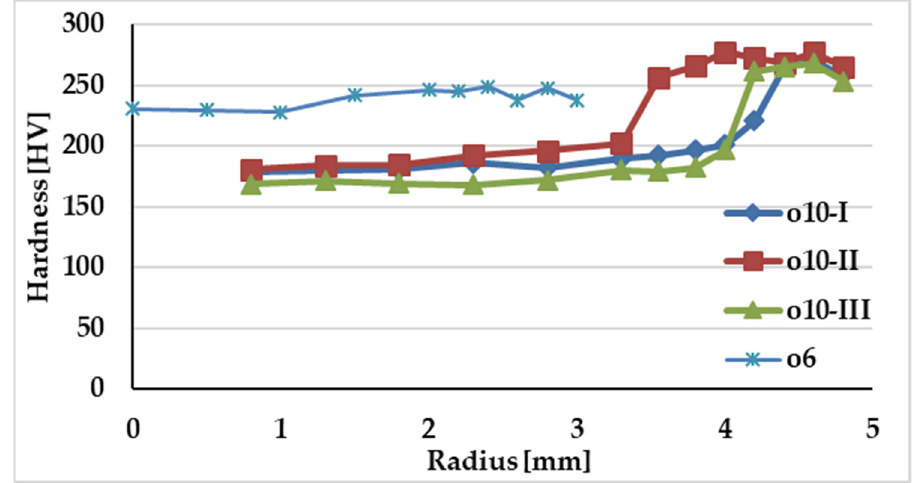
Buildings 2023 , 13 , x FOR PEER REVIEW Figure 12. Hardness distribution along the cross-section of the reinforcement ϕ 10. Figure 12. Hardness distribution along the cross-section of the reinforcement φ 10.